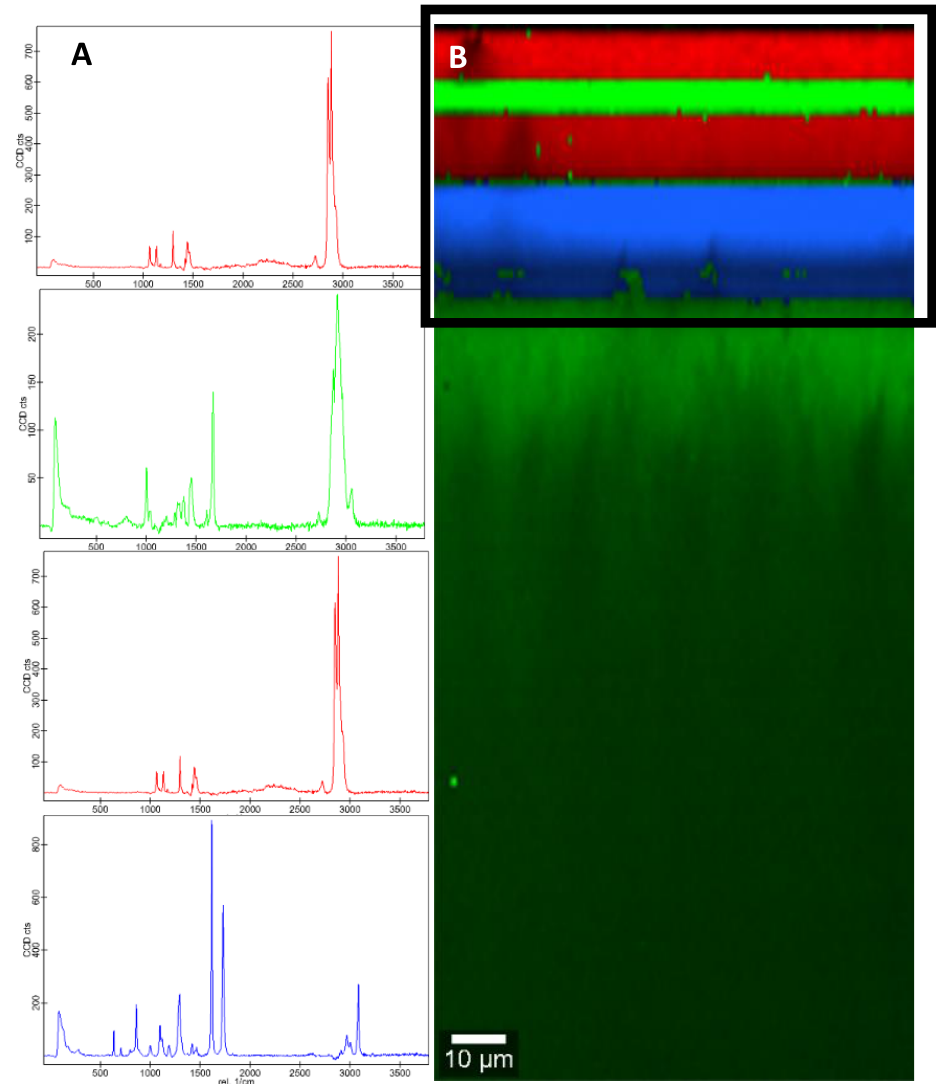
Figure 2. Raman spectra ( A ) and corresponding color-coded Raman image ( B ) of the lid of the semi-cured cheese sample.